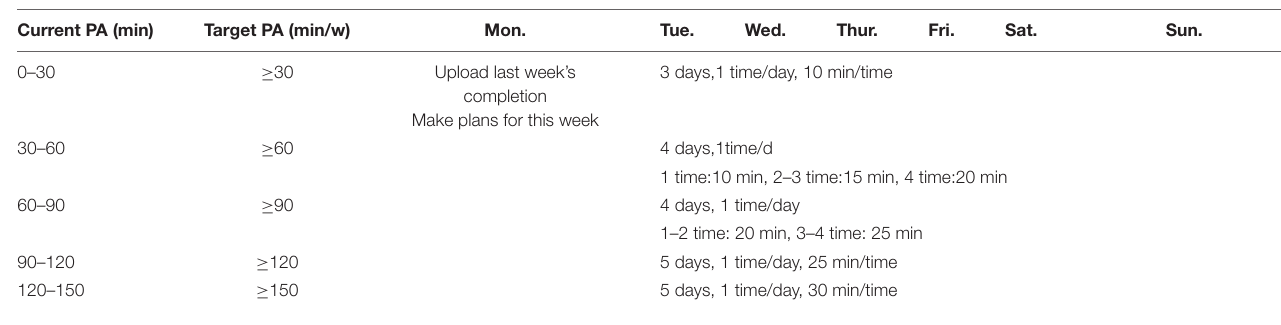
TABLE 1 | Weekly training